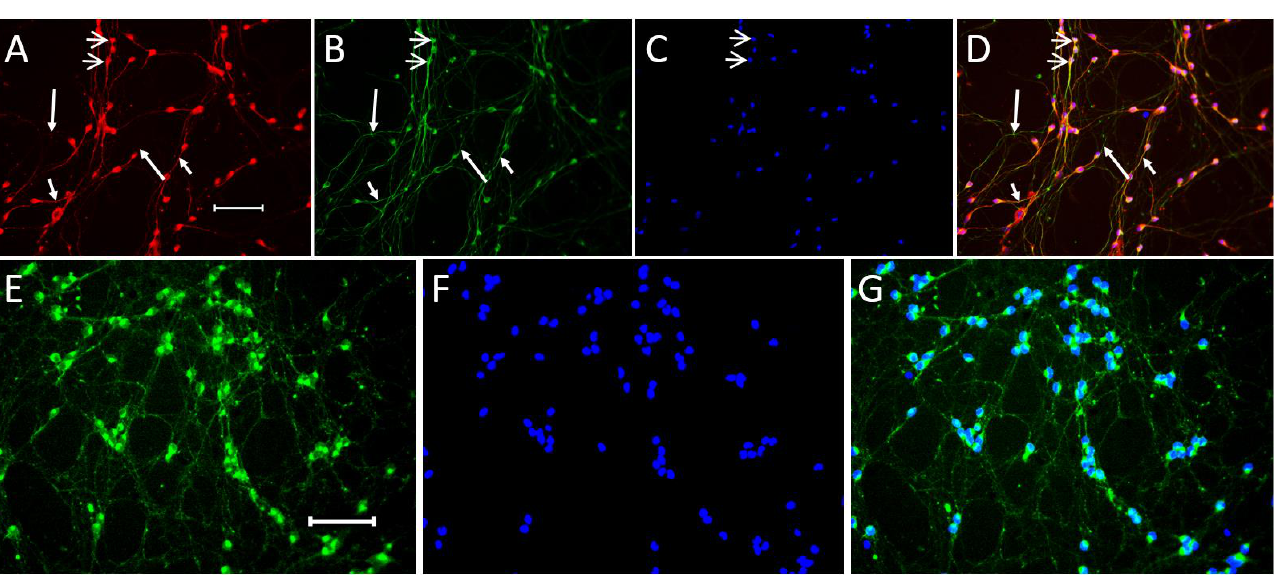
Figure 1. Neuronal marker proteins detected immunocytochemically in differentiated LUHMES cells. ( A , B , D ): Double-immunolabeling for microtubule-associated protein 2 (MAP2) (( A ), red) and β -tubulin III (( B ), green) and their colocalization (( D ); yellow). ( E , G ): synaptotagmin 1 monoim- munolabeling (green). Cell nuclei are stained with 4 ′ ,6-diamidino-2-phenylindole dihydrochloride (DAPI) (( C , F ), blue). Open arrows, double immunolabeled neurons; long arrows, neuron processes monoimmunolabeled for β -tubulin III; short arrows, neuron processes with double immunolabeling for β - tubulin III and MAP2. Bar: 100 μm.